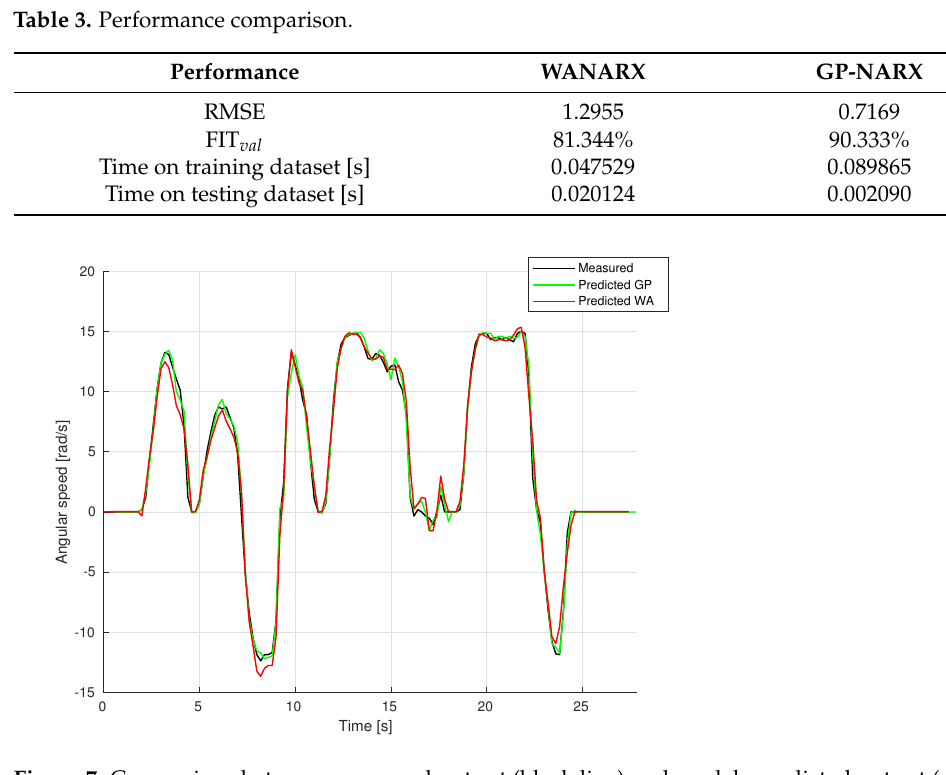
Figure 7. Comparison between measured output (black line) and models predicted output (green line for GP-NARX, red for